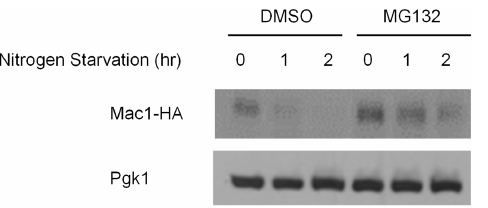
Figure 5. Mac1 is regulated by proteasome-dependent protein degradation under nitrogen starva- tion. To identify the mechanism of Mac1 regulation by nitrogen starvation, MG132, which is a pro- teasome inhibitor, was used. The cells were starved of nitrogen with or without MG132 in the me- dium, total proteins were extracted, and then, western blotting was performed. PGK1 was used as a loading control.